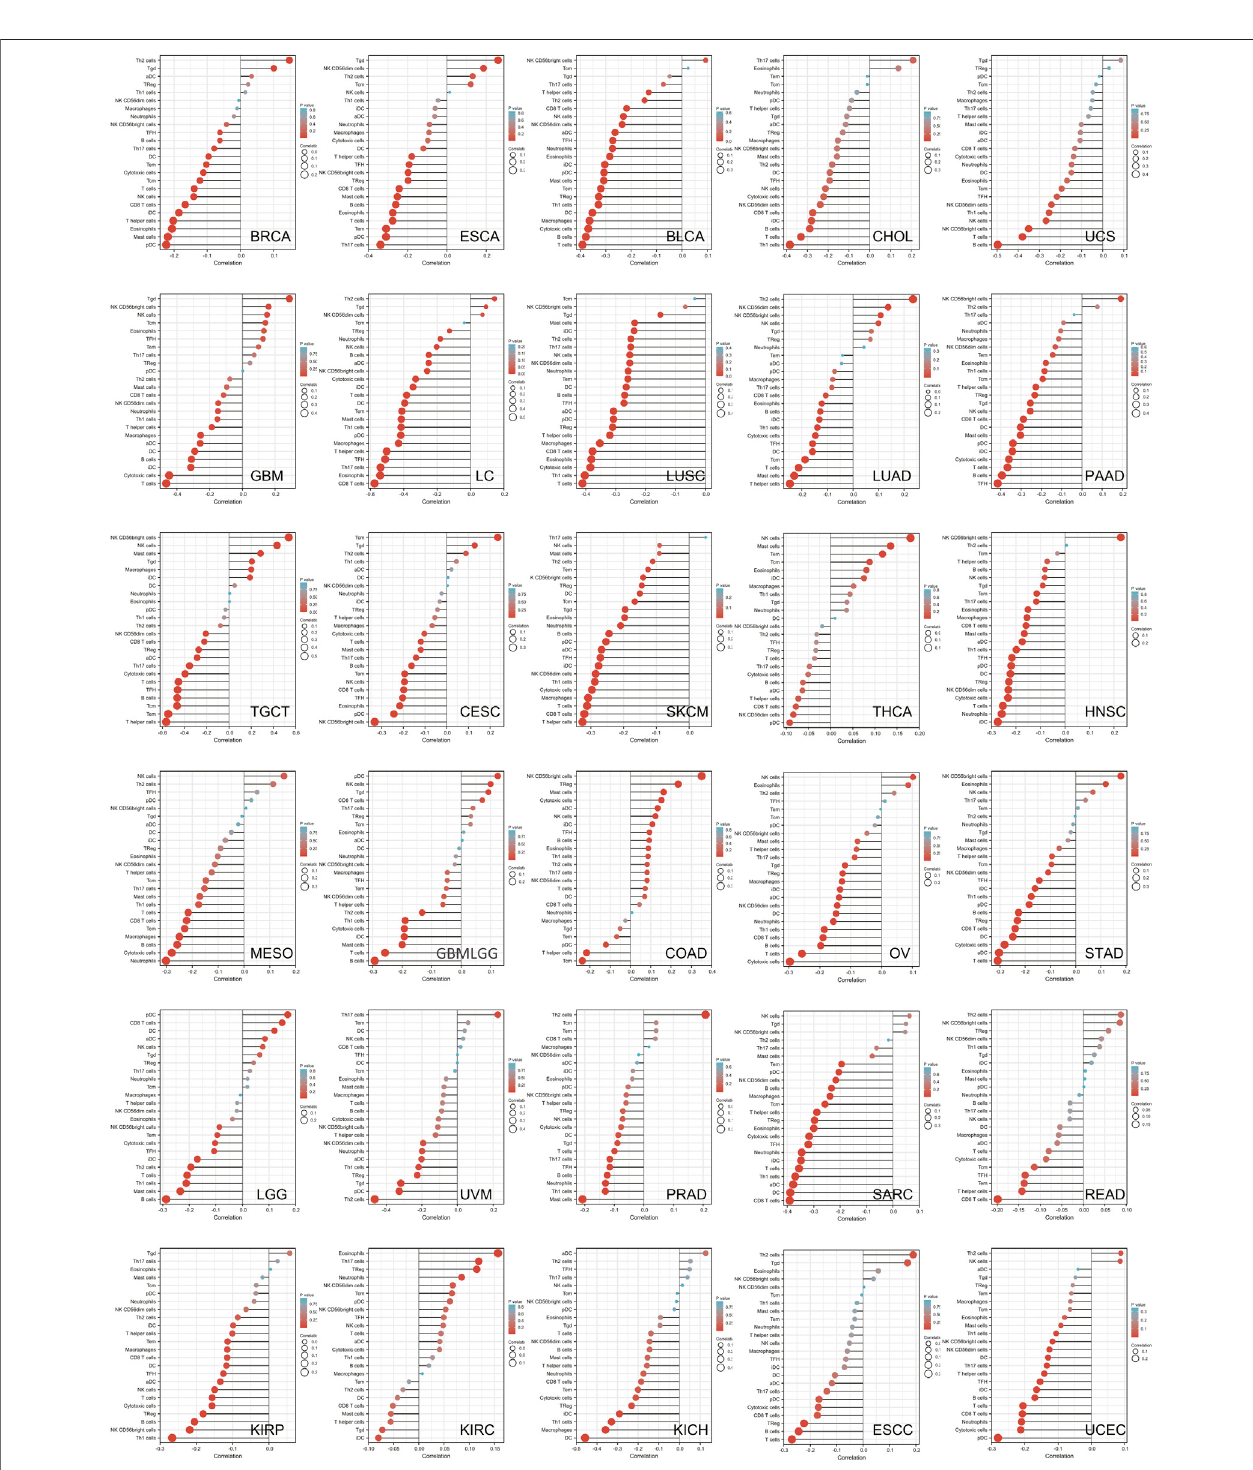
FIGURE 9 | The stick charts showing the relationship between SLC6A8 expression and levels of diverse tumor-in fi ltrating immune cells in various cancers.